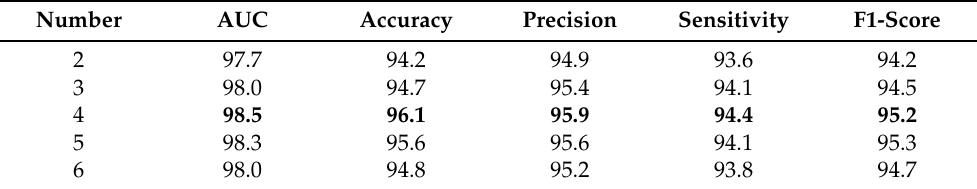
Table 3. Performance comparisons of the different number of DDFormer blocks.